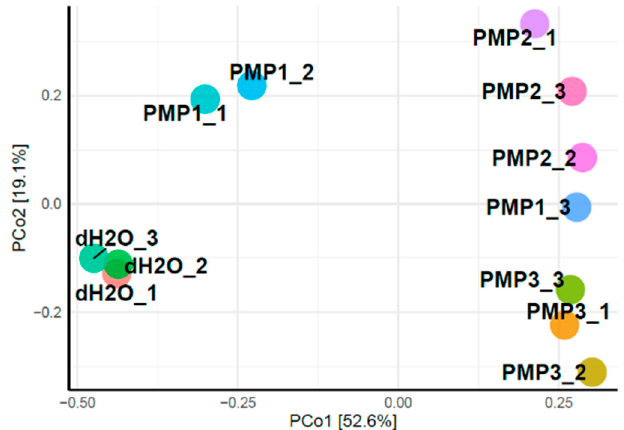
Figure 9. Principal coordinates analysis (PCoA) classified and clustered distinctly bacterial leaf microbiome samples according to similarities of their identified OTUs.